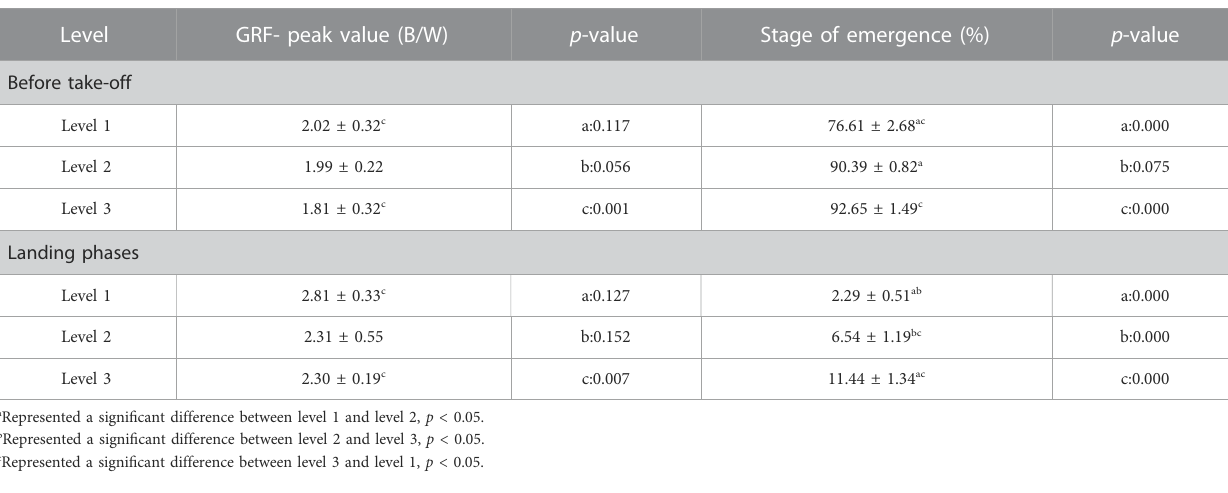
TABLE 5 Timing characteristic of GRF in level 1, level 2, and level 3 during takeoff and landing phases.